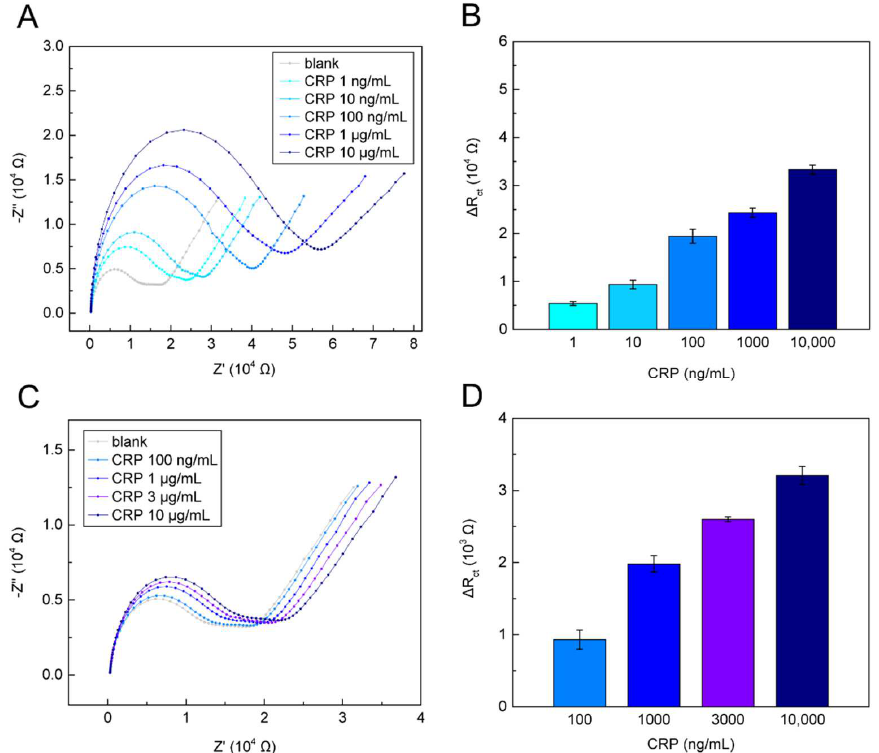
Figure 5. C-reactive protein (CRP) detection performance of the microfluidic platform: The Nyquist plots of EIS measurements and the calculated measured CRP concentrations ( n = 3) in the detection of CRP spiked in ( A , B ) plasma and ( C , D ) whole blood samples.